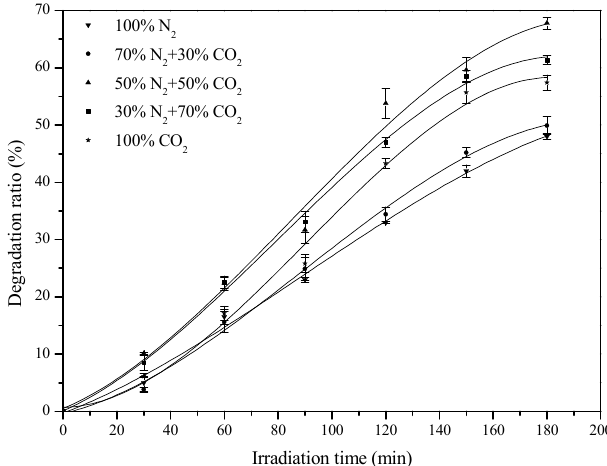
Figure 6. Effect of CO 2 concentration on the chlorobenzene degradation ratio of Cu 2+ /K 2 La 2 Ti 3 O 10 at 500 °C.